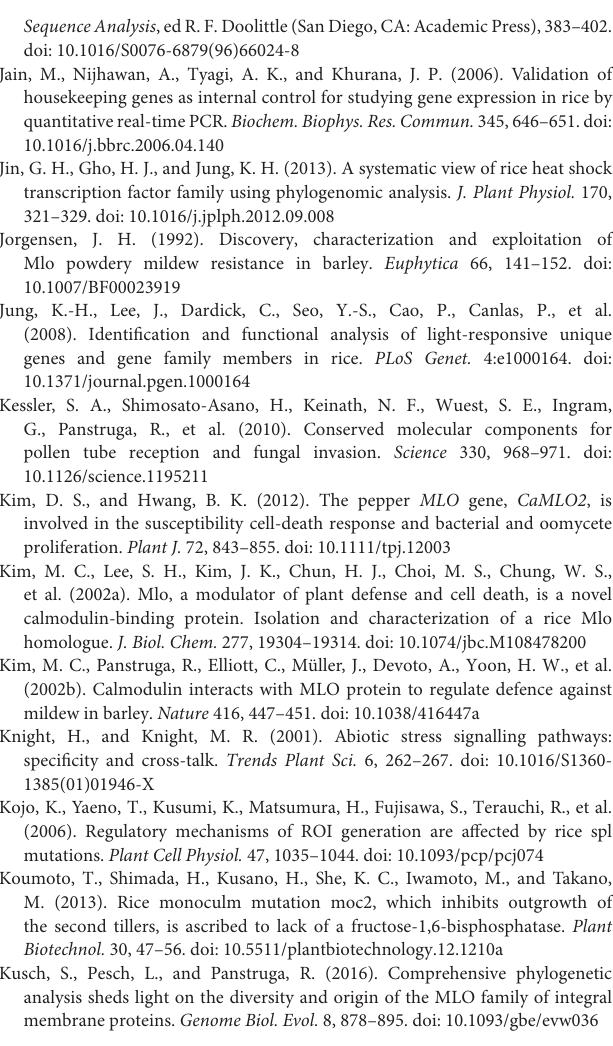
Table S2 | Details of microarray data for OsCaM and OsCML genes examined in this study with wild-type rice and osdxr mutant. Table S3 | Summary of co-expression genes with OsMLO1, 2, 3, 4, 8 , and 9 genes in 2532 anatomical samples using co-expression analysis tool in